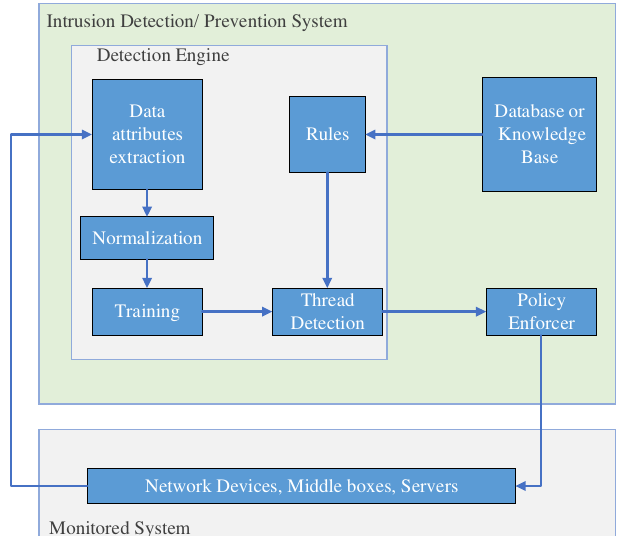
Figure 2. General